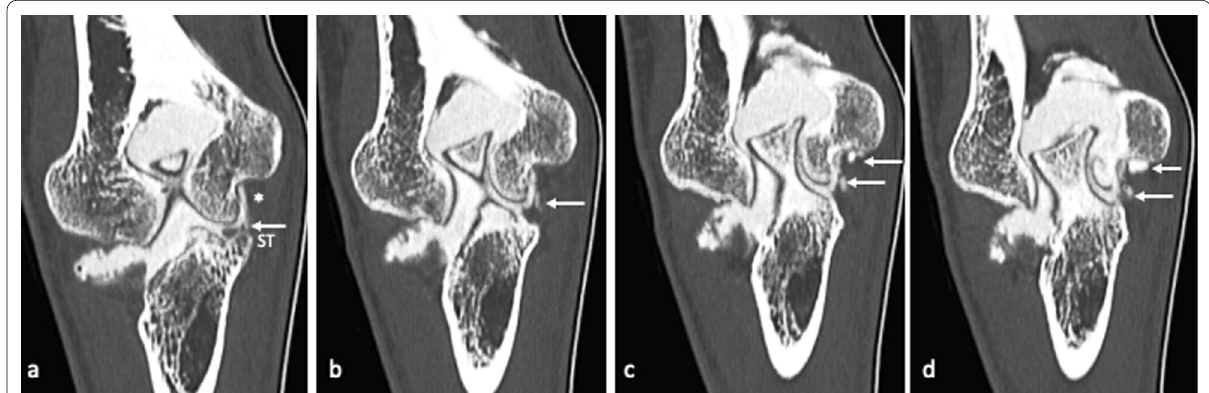
Fig. 6 Professional tennis player with micro-tearing of the anterior band (A-MCL). Oblique coronal reformatted images depicting the A-MCL along its longitudinal axis, up to its insertion at the sublime tubercle (ST), highlight a thickened ligament (asterisk) with multiple strands of contrast enhancement within its fibers, due to micro-tearing (white arrows)